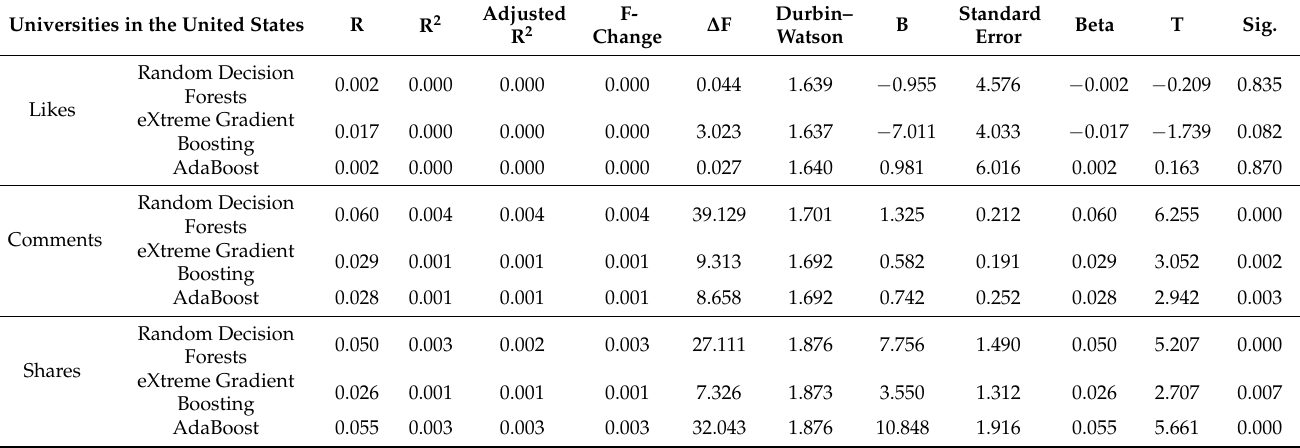
Table 2. Linear regression coefficient of determination and beta (universities in the United States).